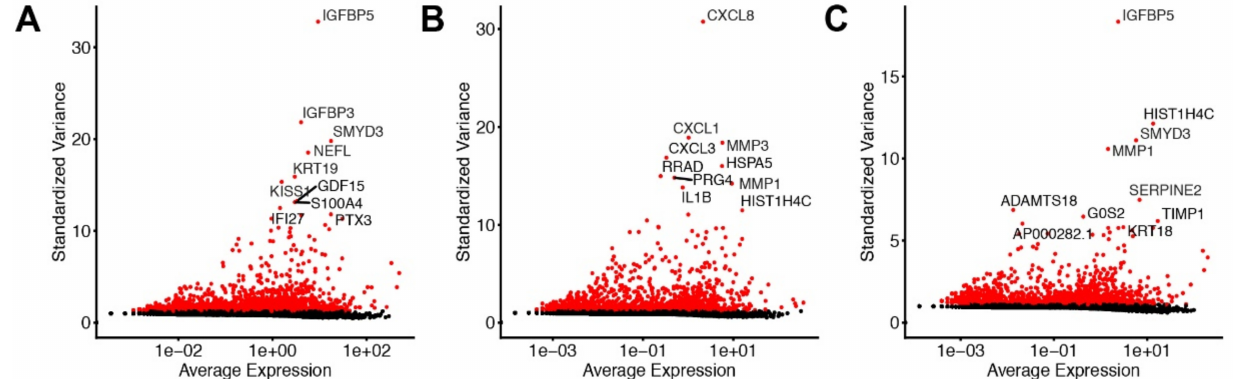
Figure 1. Immunocytochemistry of EpCAM in disease-associated fibroblasts from pancreatic cancer and chronic pancreatitis patients. ( A ) Panc-1 cells stained as positive control, ( B ) cells from patient1, ( C ) from patient2, and ( D ) from patient3. Bar: 50 µ m.